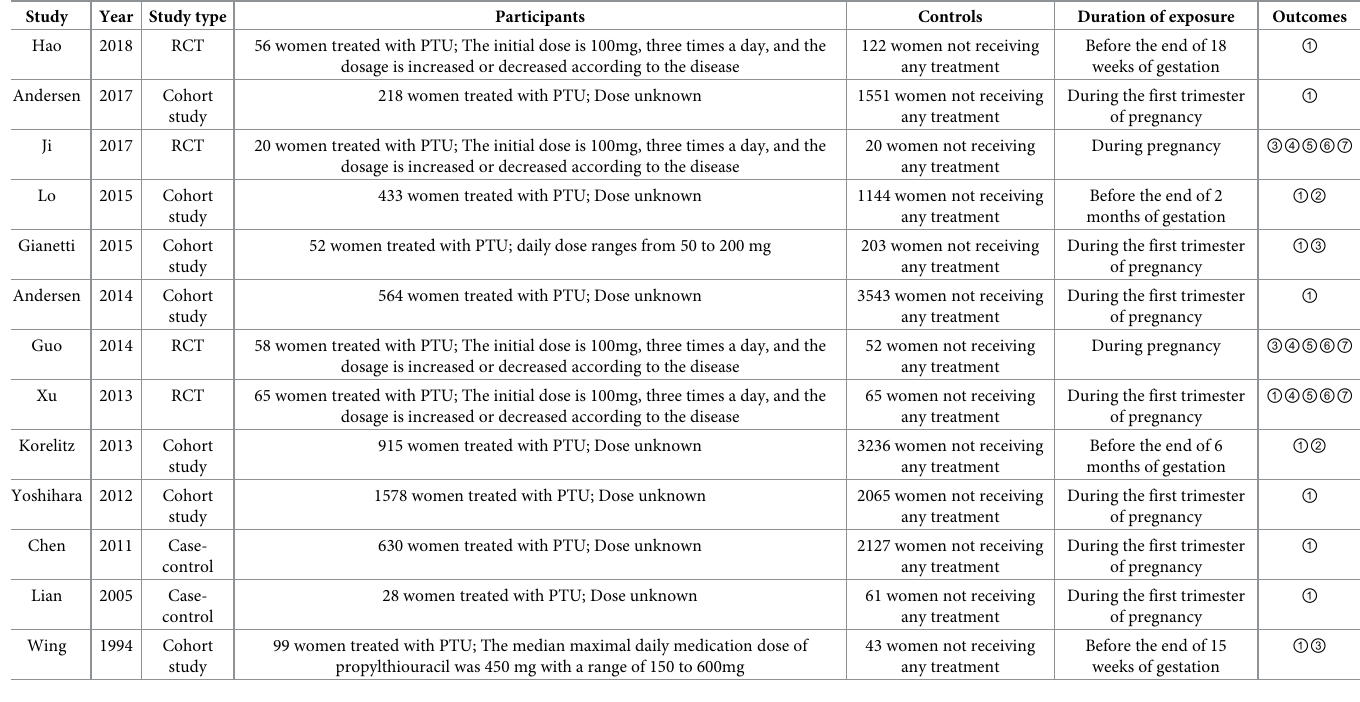
Table 1. Characteristics of included studies.